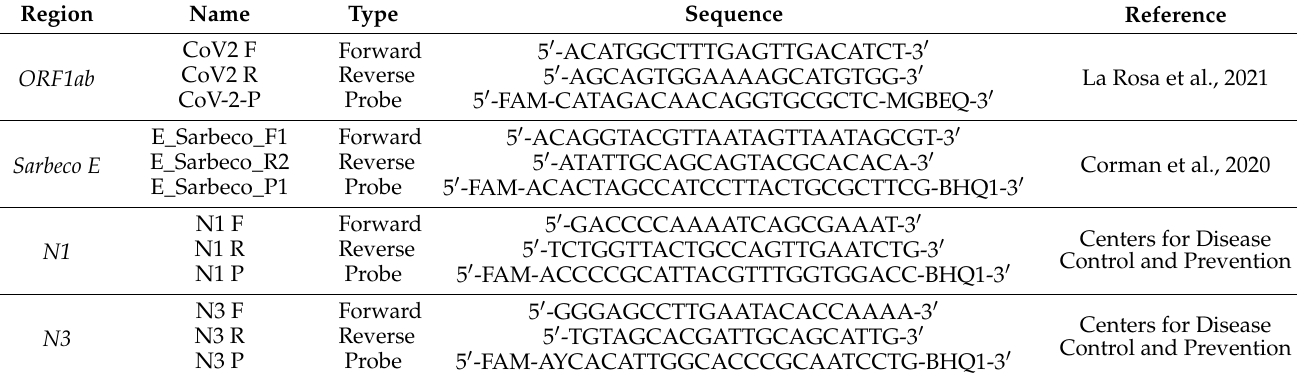
Table 1. Primers and probes used to detect SARS-CoV-2 in One-Step RT Real-time